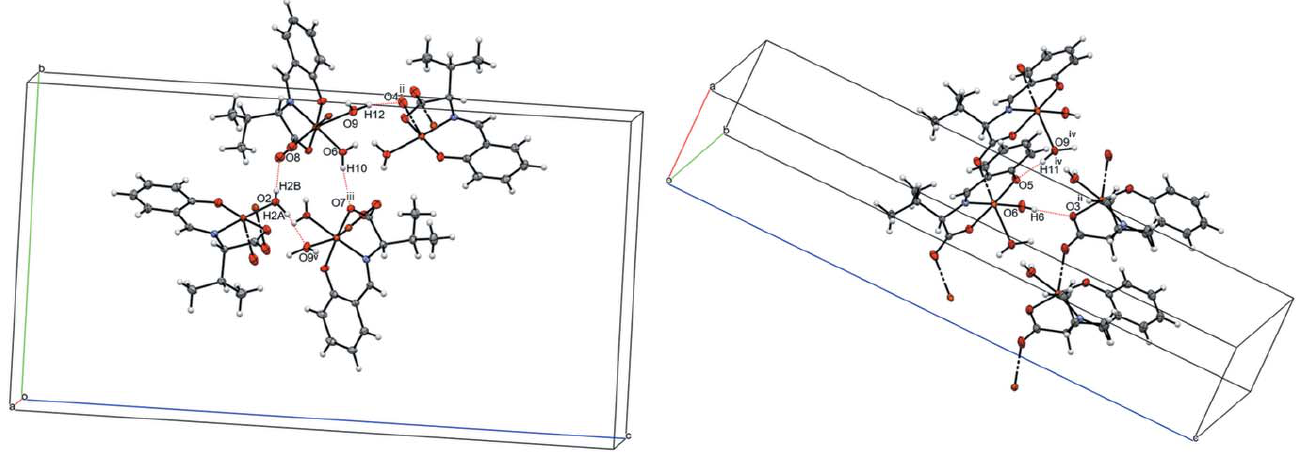
Figure 2 Aview of the intra- and intermolecular O—H (cid:2)(cid:2)(cid:2) O hydrogen bonds, shown as dashed lines. [Symmetry codes: (ii) x + 3 (cid:5) z + 1; (iv) x (cid:5) 1, y , z ; (v) x + 1, y , z .]